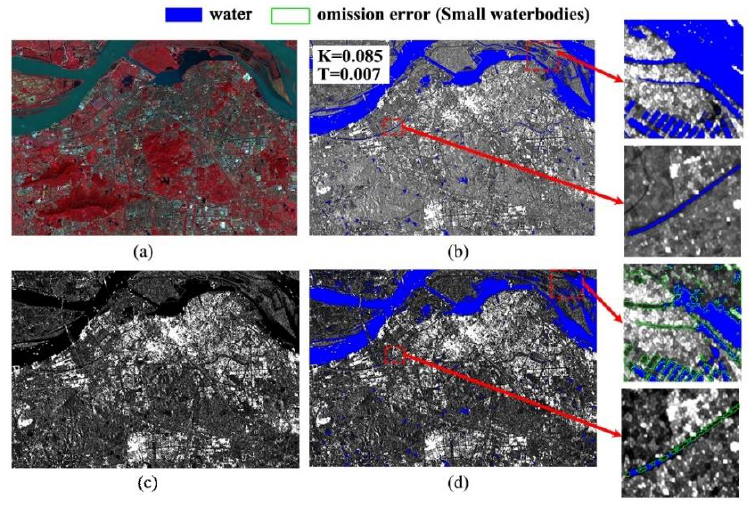
Figure 14. Waterbody extraction map for Yangzhou, Jiangsu: ( a ) Optical image. ( b ) Water extraction based on the SOWI. ( c ) SAR image. ( d ) Water extraction based on VV.